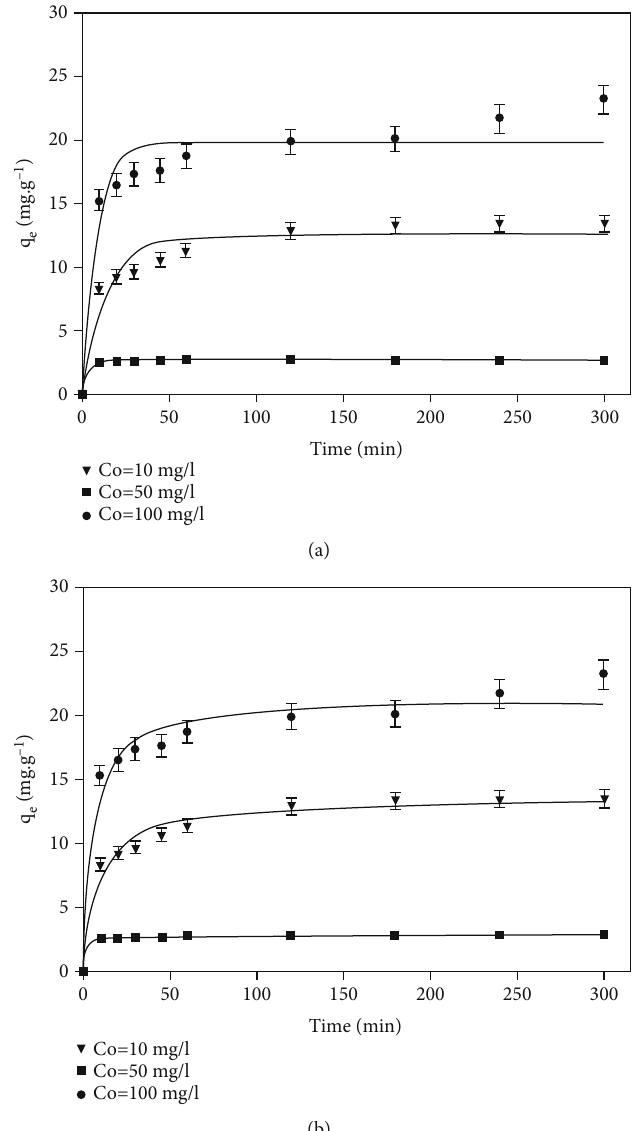
Figure 7: (a) Pseudo 1st order kinetic model and (b) pseudo 2nd order kinetic model for the best adsorption